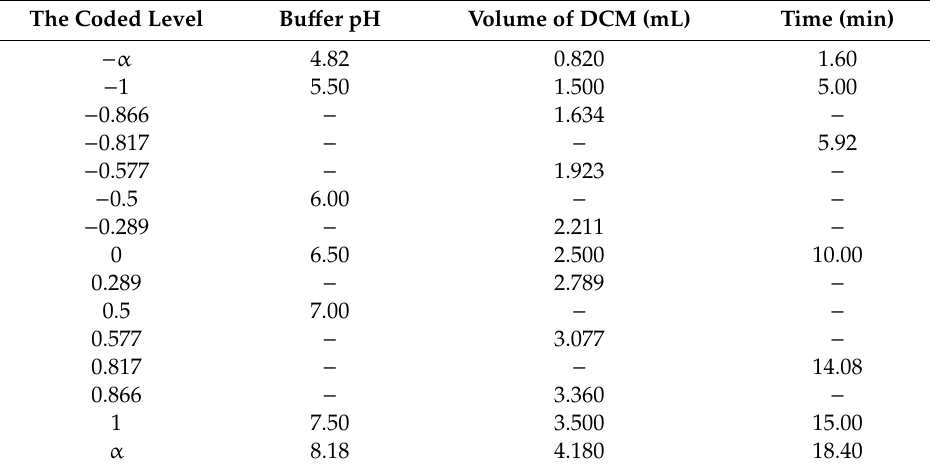
Table 4. The levels of the